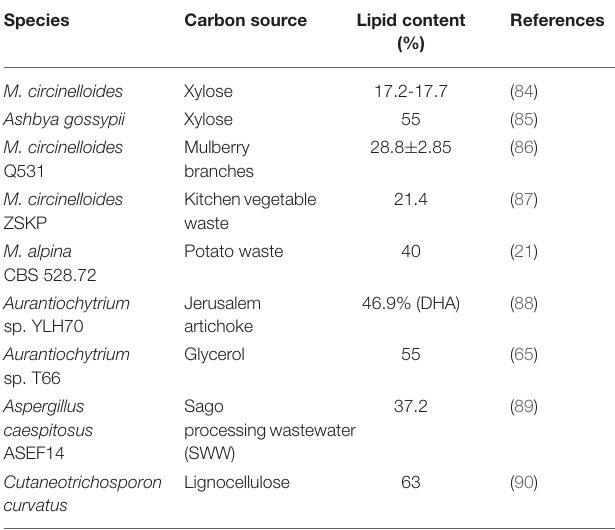
TABLE 2 | Non-glucose substrates for lipid